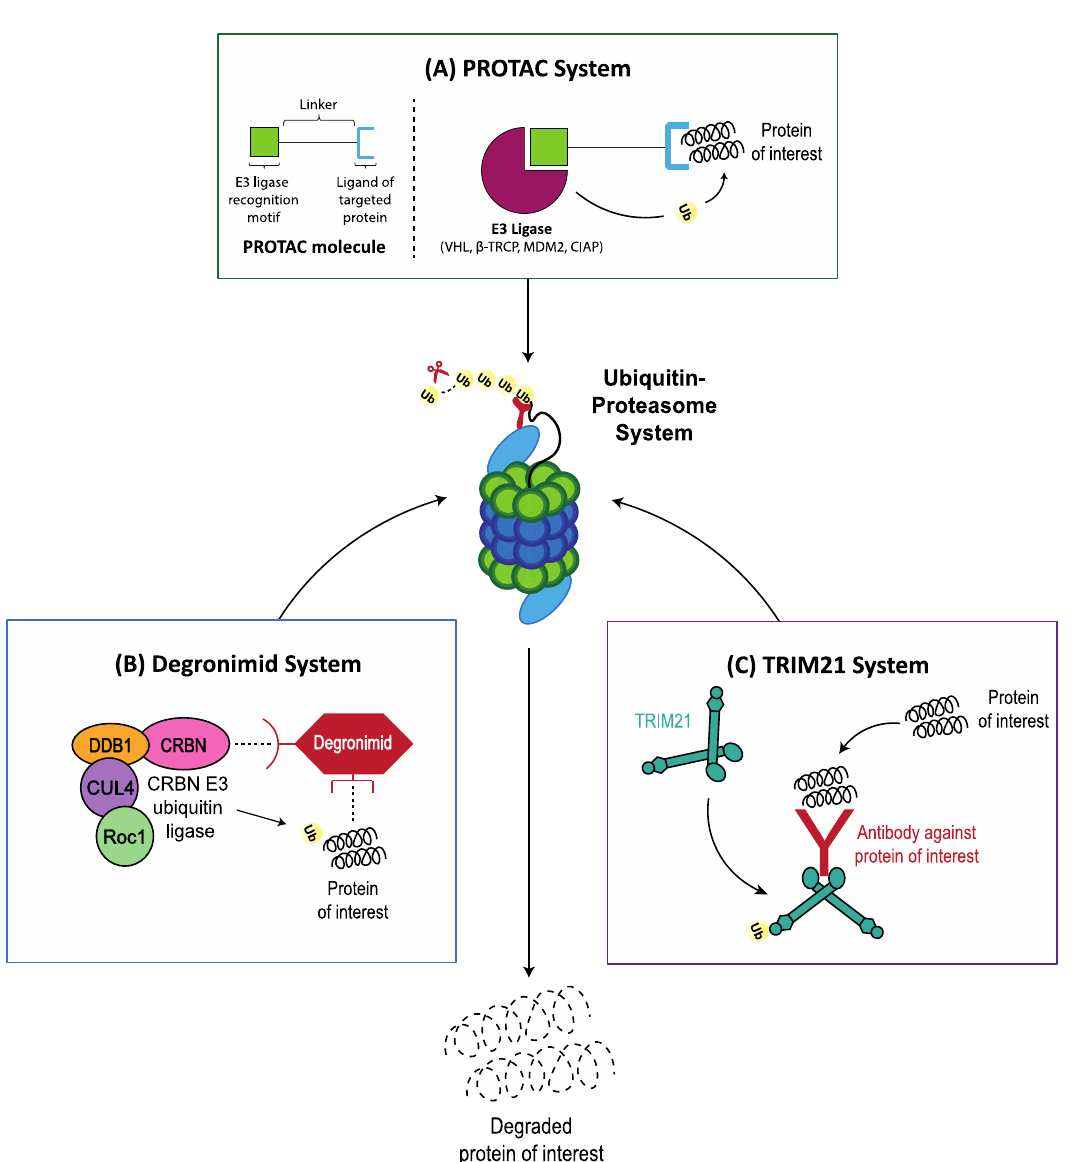
Figure 2. Hijacking the ubiquitin proteasome system (UPR) for targeted protein degradation. Targeted protein degradation has recently emerged as an attractive and promising approach against currently undruggable (and druggable) targets. ( A ) the PROteolysis Targeting Chimera (PROTAC) system: PROTACs are heterobifunctional molecules that serves as a bridge by binding to an E3 ligase on one side and to the protein of interest on the other, thereby facilitating polyubiquitination and proteasome degradation of the protein of interest. ( B ) deronimids are specifically modified immunomodulatory drugs (IMiDs) that recruit the Cereblon E3 ubiquitin ligase to the protein of interest to facilitate target proteasome degradation. ( C ) TRIM21 is an E3 ubiquitin ligase that recognizes and polyubiquitinates antibody-bound substrates by binding with high affinity to the Fc domain of